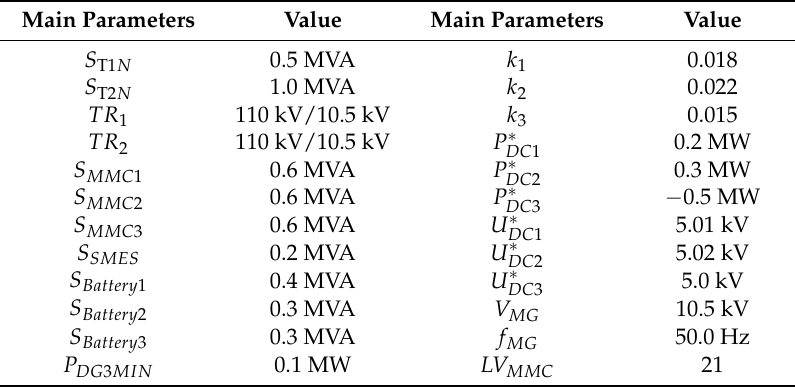
Table 3. Main parameters of the simulation model.